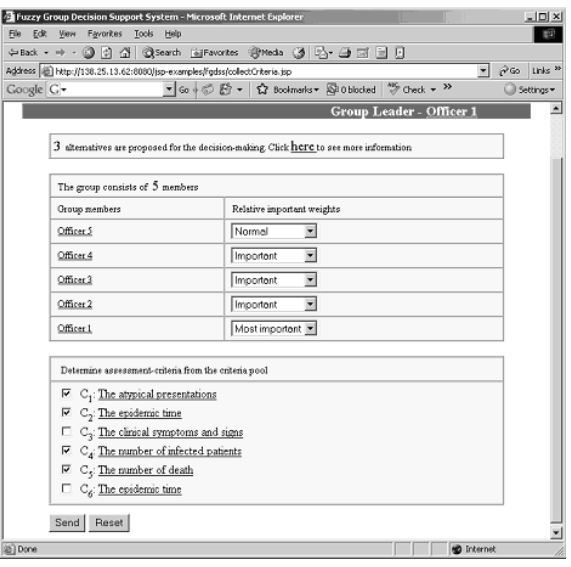
Fig. 4. Four criteria and team members’ weights